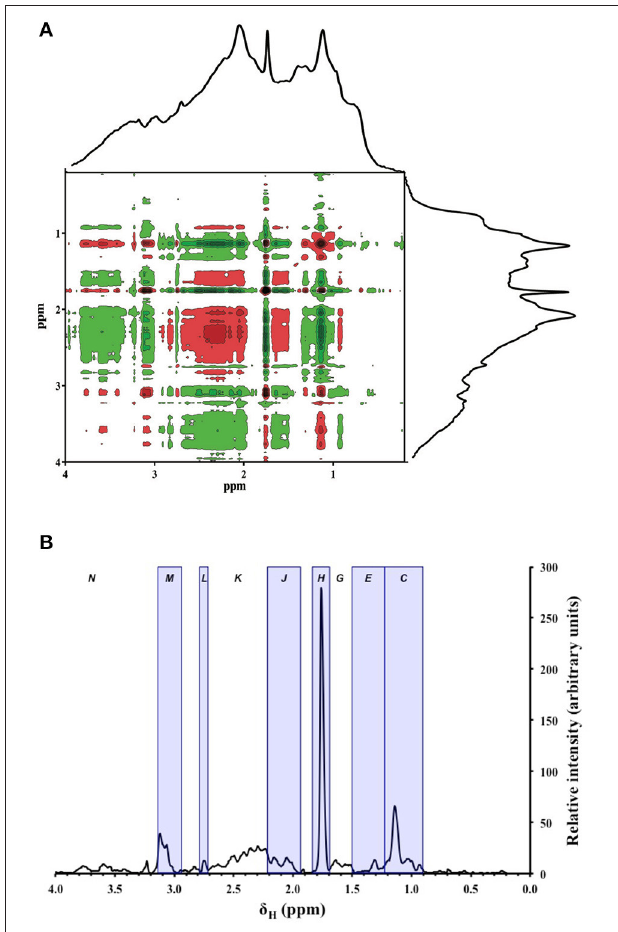
FIGURE 4 | (A) Synchronous 2D correlation map generated from all of the 1 H NMR spectra ( n = 21) obtained on the 400 MHz instrument. Peaks that appear along the dashed diagonal line (auto-correlation peaks, or autopeaks) indicate chemical shift regions whose intensities changed significantly with depth ( p ≤ 0.05). Peaks that appear in the off-diagonal (cross peaks) indicate positive (red) and negative (green) correlations among different parts of the spectrum ( p ≤ 0.05). Stronger color intensity represents stronger correlation. The average 1 H NMR spectrum is shown at the top and to the right of each plot. Letters indicate peak/band assignments given in Table 2 . (B) Relative intensities of autopeaks that appear along the diagonal in panel (A). Letters indicate peak and band assignments. Peaks are encased in blue